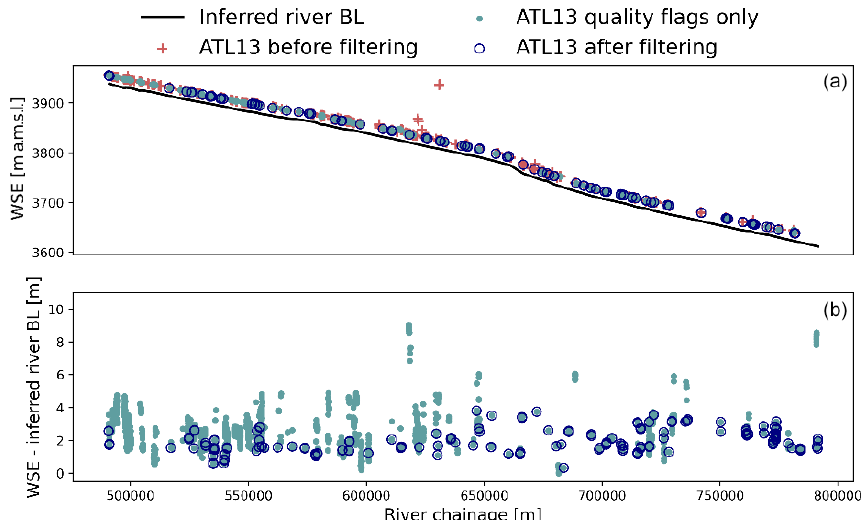
Figure 6. (a) ATL13 WSE along-river chainage before processing, after quality filters are applied, and after filtering criteria. (b) ATL13 WSE minus inferred BL from the model calibration is determined by comparing the quality filters results and the filtering